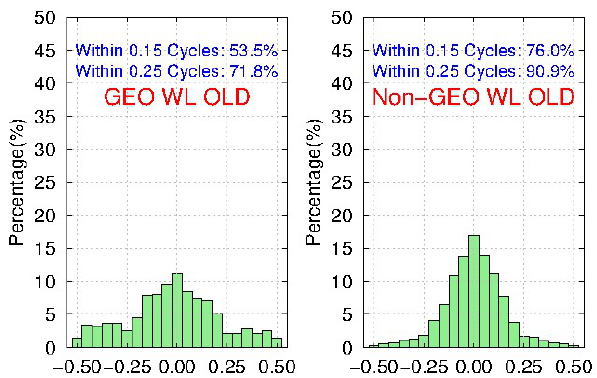
Figure 11. The distribution of BDS WL fractional parts after removal of FCBs estimated by the traditional strategy for 103 MGEX stations during DOY 061-090, 2018.